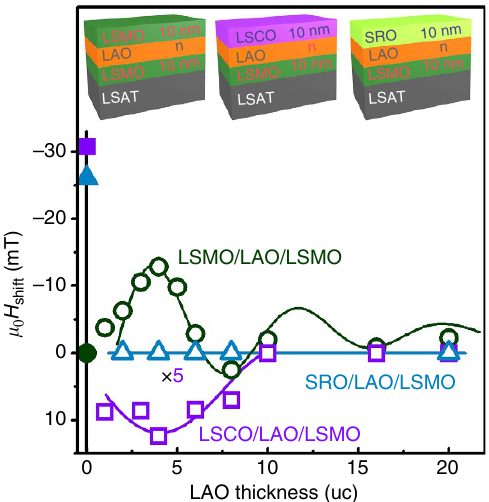
Figure 4 | The loop shift for a 10nm La 0.67 Sr 0.33 MnO 3 bottom layer with different top layers. There is no shift for SrRuO 3 , which is a nonpolar metal. The shift for La 0.67 Sr 0.33 CoO 3 , which is polar but with the opposite signs of spin–orbit coupling, is opposite to that of La 0.67 Sr 0.33 MnO 3 .